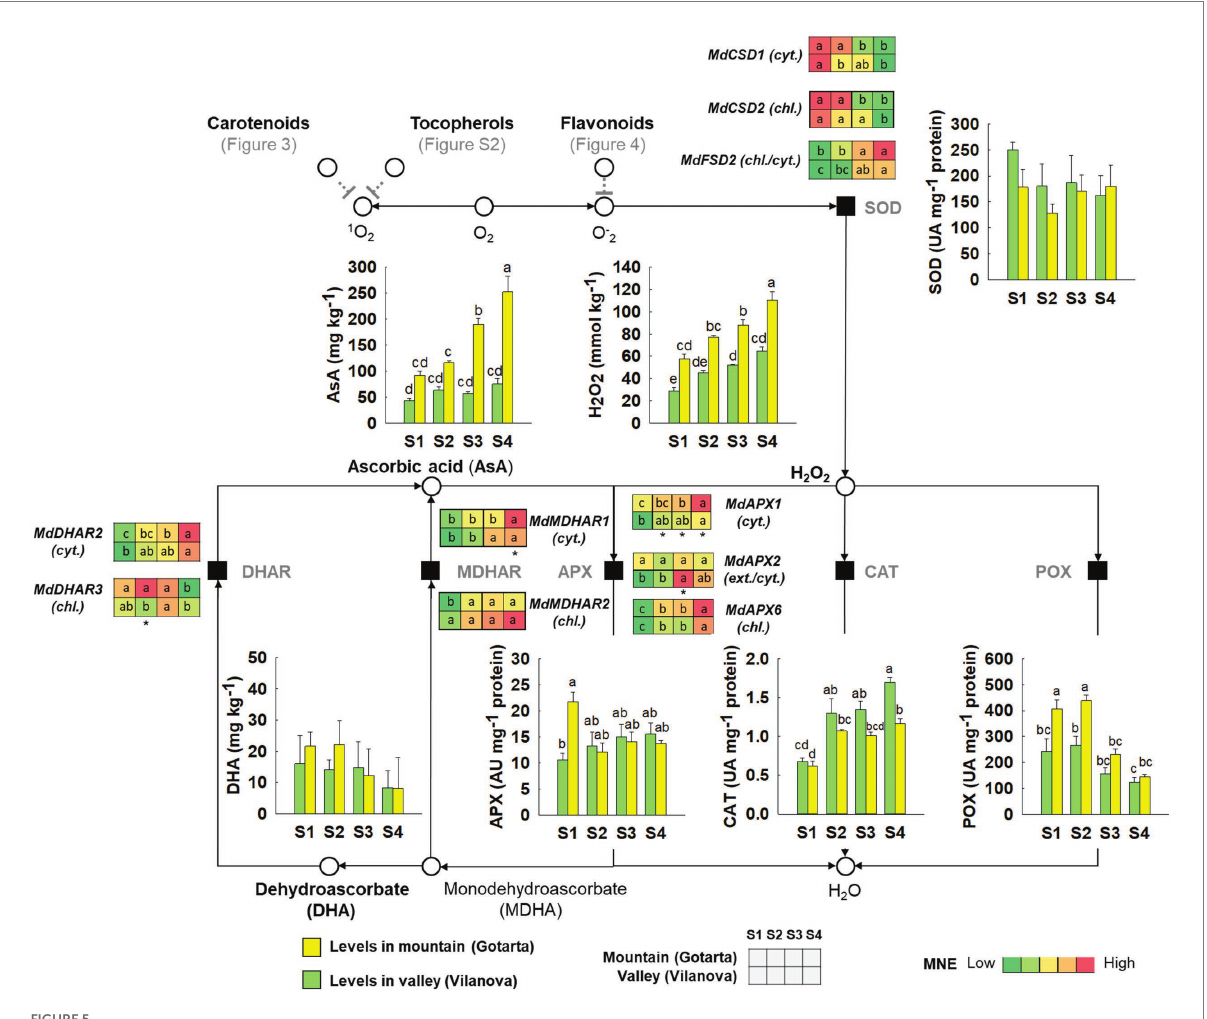
FIGURE 5 Comparative overview of the ROS-scavenging metabolism and ascorbate recycling pathway of “Golden Reinders” apples grown in mountain (Gotarta- ) or valley (Vilanova- ) orchards during fruit development/ripening. The activity of the main antioxidant enzymes, as well as the content of ascorbic acid and H 2 O 2 , is represented in bar plots. Error bars represent the standard error ( n = 4). Letters, whenever available, indicate significant differences for the interaction location*stage according to Tukey test ( p ≤ 0.05). The corresponding transcript levels of the main genes are represented as heatmaps. Letters indicate significant differences ( p ≤ 0.05) between development stages, while asterisk denote differences among locations at each specific development